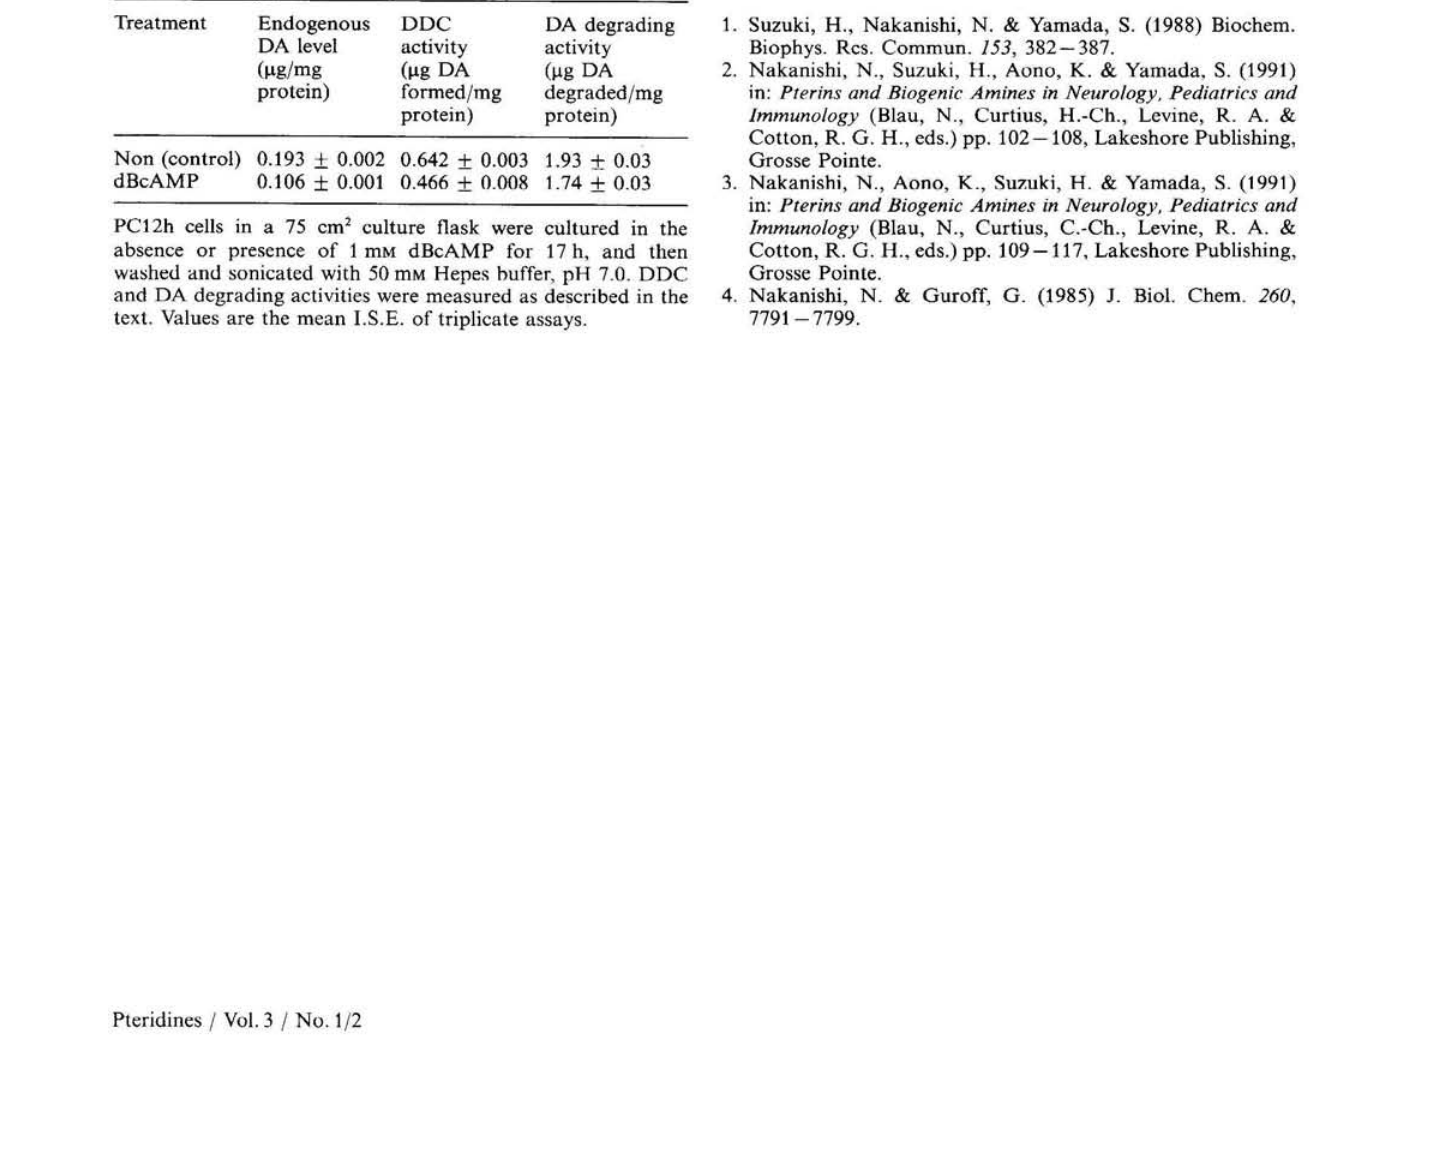
Table 2. Effect of dBcAMP treatment on dopa decarboxylase (DDC) and DA degrading activities of PC12h pheochromocy- toma